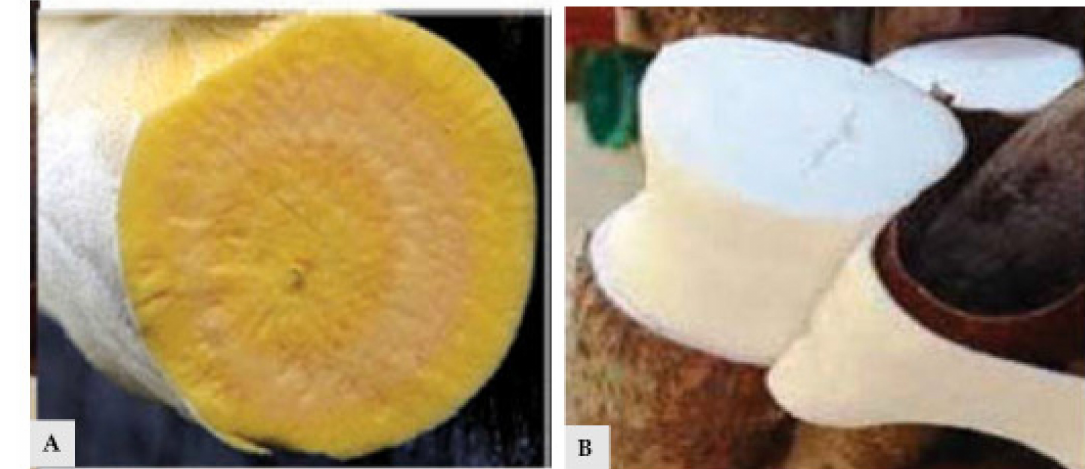
Figure 5. Pictures of cross-section of cassava root. ( A ) Pro-vitamin A cassava variety UMUCASS 36. ( B ) White cassava variety TME 419. Source: